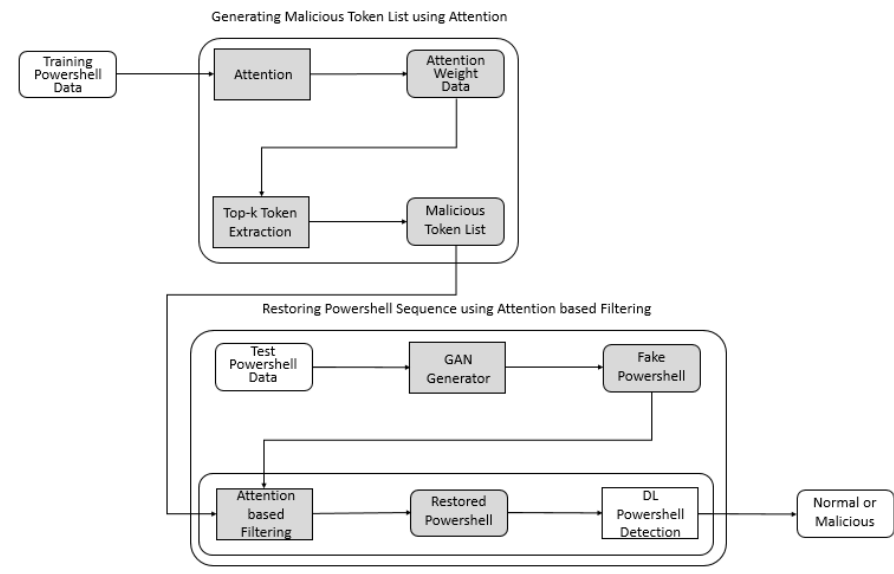
Figure 1. Malicious PowerShell Detection System Using Attention against Adversarial Attacks.